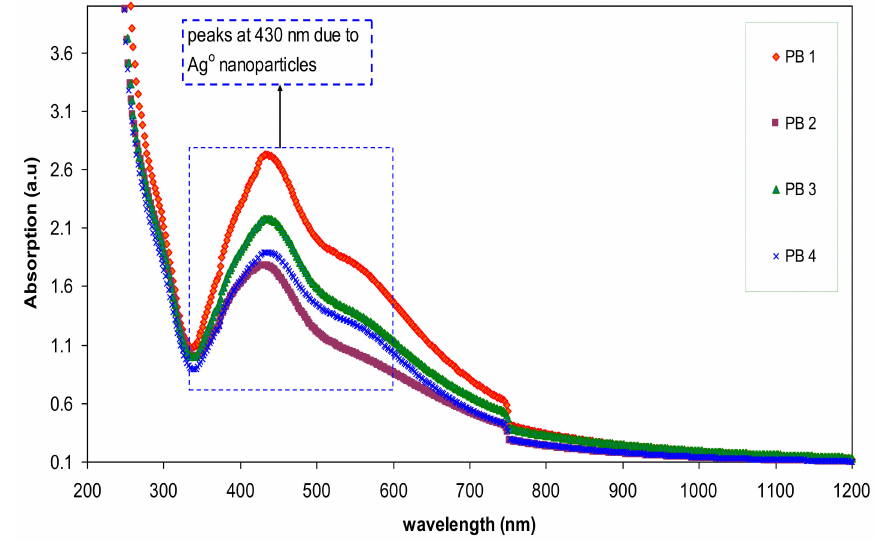
Figure 10. Absorption spectra of nanocomposite blend